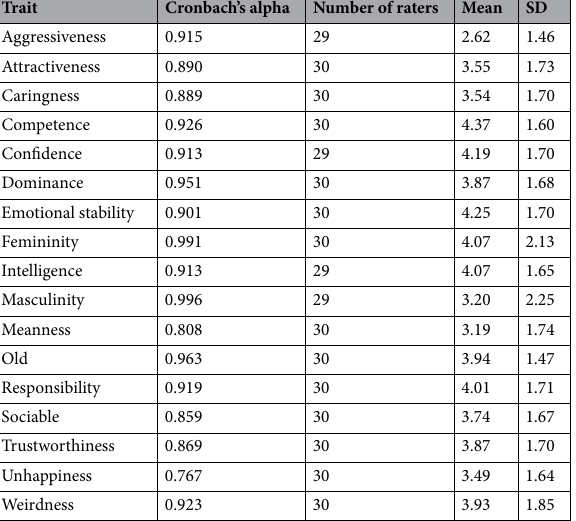
Table 1. Cronbach’s alpha for each trait, number of raters who rated voices for each trait, mean rating for each trait, and standard deviation (SD) in Study